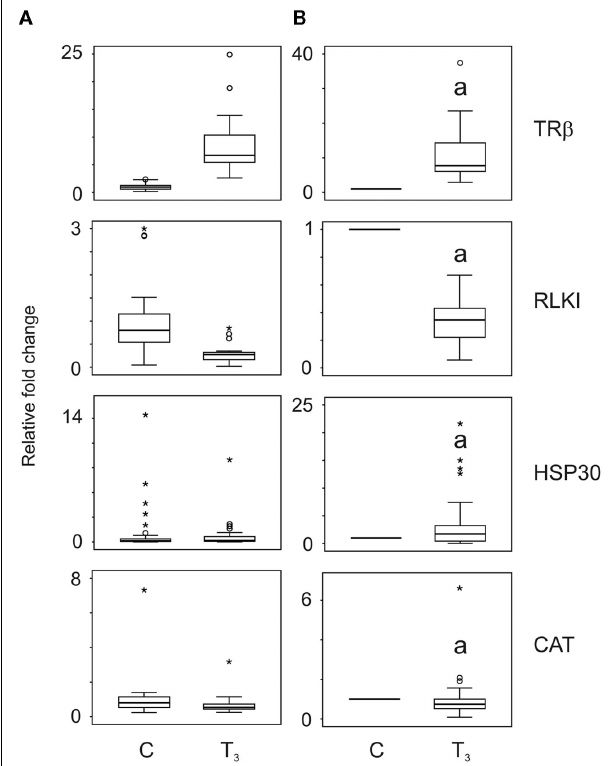
FIGURE 1 |The effect of application of repeated measures analysis on QPCR data generated for thyroid hormone receptor β ( TR β ), Rana larval keratin I ( RLKI ), heat shock protein 30 ( HSP30 ), and catalase ( CAT ) transcripts. Tail fin biopsies were exposed to vehicle control (C) or 10nM T 3 .The data ( n = 23–32) are plotted as independent measures in (A) and then as repeated measures in (B) .Taking the individual’s baseline expression levels greatly reduces overall variation and enables the identification of perturbation of a response toT 3 relative to each individual’s normalT 3 response. Box plots show medians ± first and third quartiles.The whiskers indicate minimum and maximum values excluding outliers and extreme values. Outlier (cases between 1.5 and 3.0 box lengths from the upper or lower edge of the box) and extreme values (cases > 3.0 box lengths from the upper or lower edge of the box) are indicated by an open circle and asterisk, respectively. Statistical significance is indicated with the letter “a” for p <